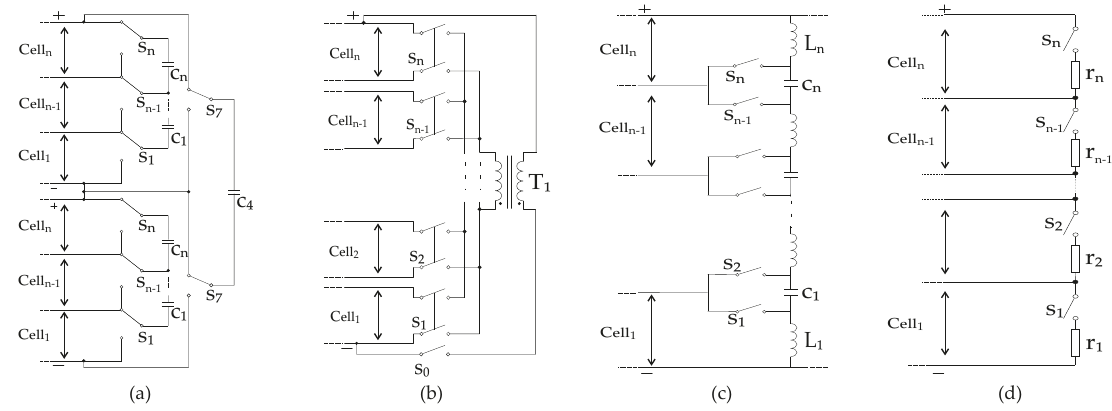
Figure 1. Several balancing topologies: ( a ) Modularized switched capacitor; ( b ) Switch matrix transformer; ( c ) Cuk converter; and ( d ) Switched shunt resistor.